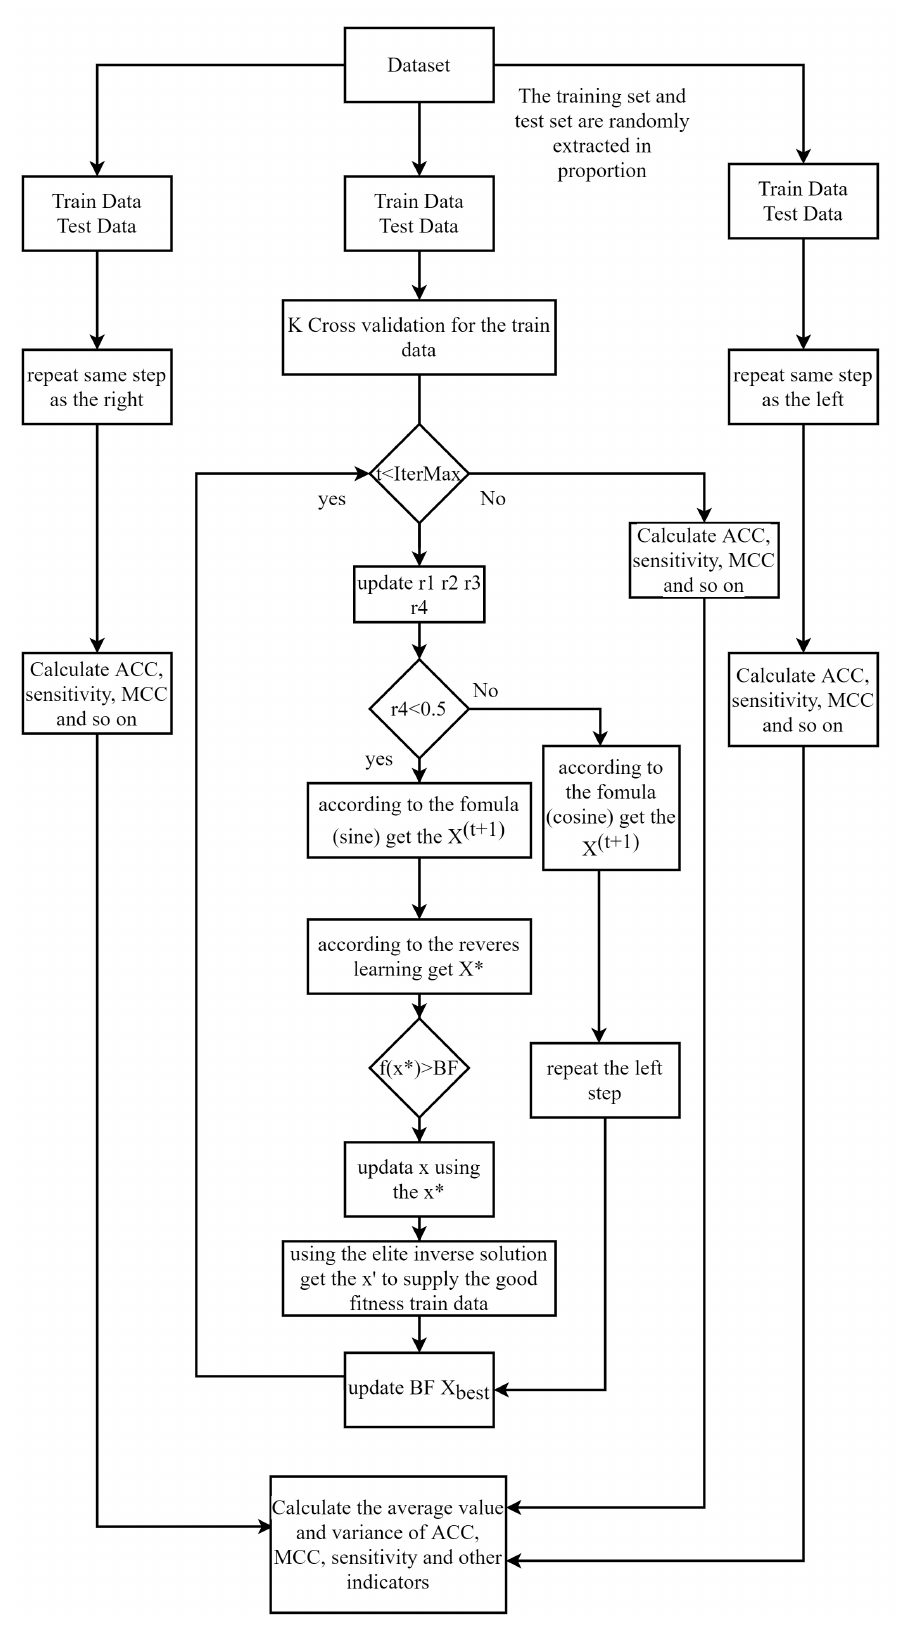
Figure 3. The flow chart of the hybrid SCA